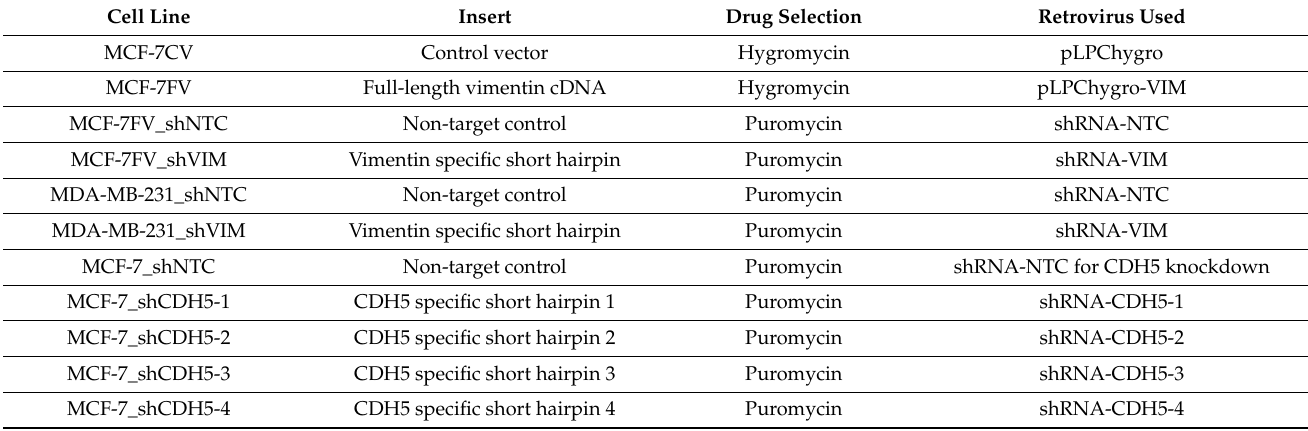
Table 1. Transduced cell lines used in the